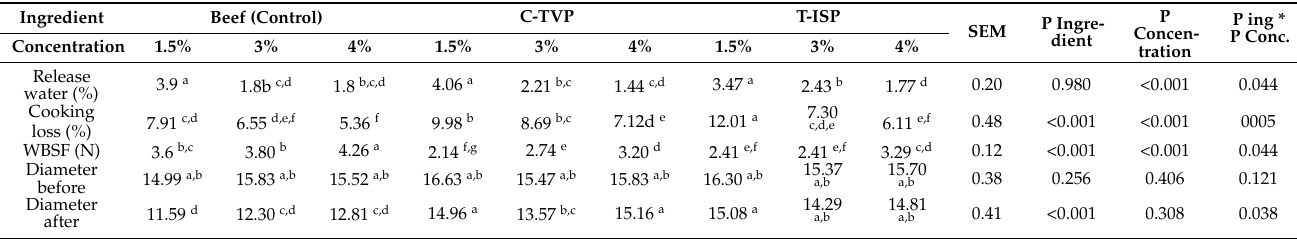
Table 4. Water-holding capacity and tenderness related measurement of plant-based meat and control (beef) with different concentration of